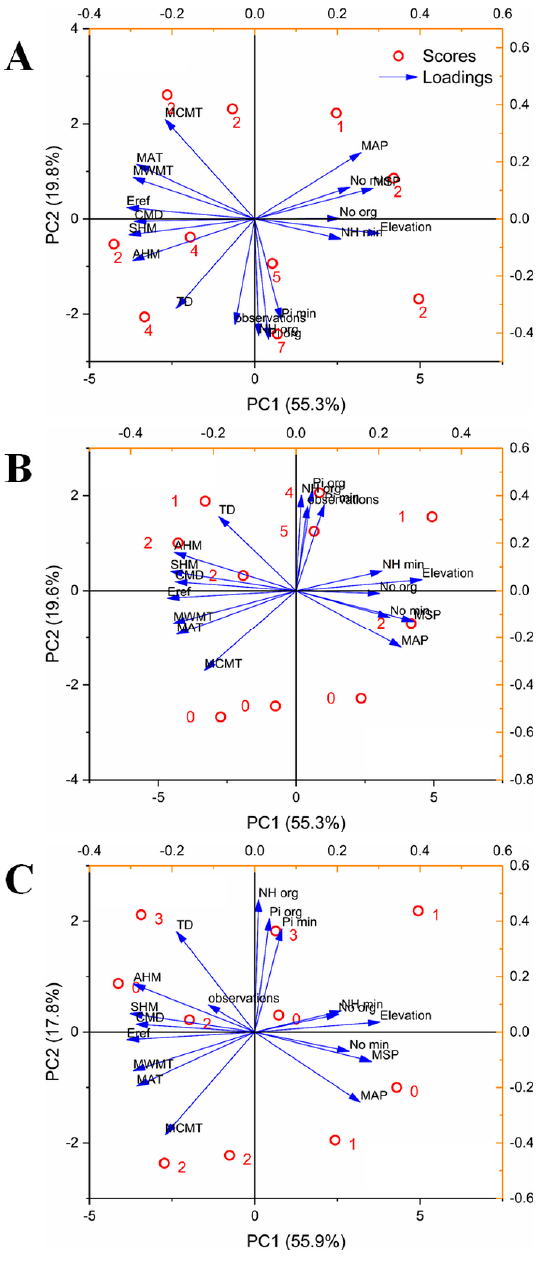
Figure 3. PCA analyses of fold changes of physiological parameters and growth conditions in the natural habitats of the beech saplings analyzed. Red dots and red numbers indicate the total number of significant fold changes upon drought ( A ), in leaves ( B ), and in the fine roots ( C ). Parameters describing growth conditions in the habitats of origin are given in black. The data are taken from Table 6.